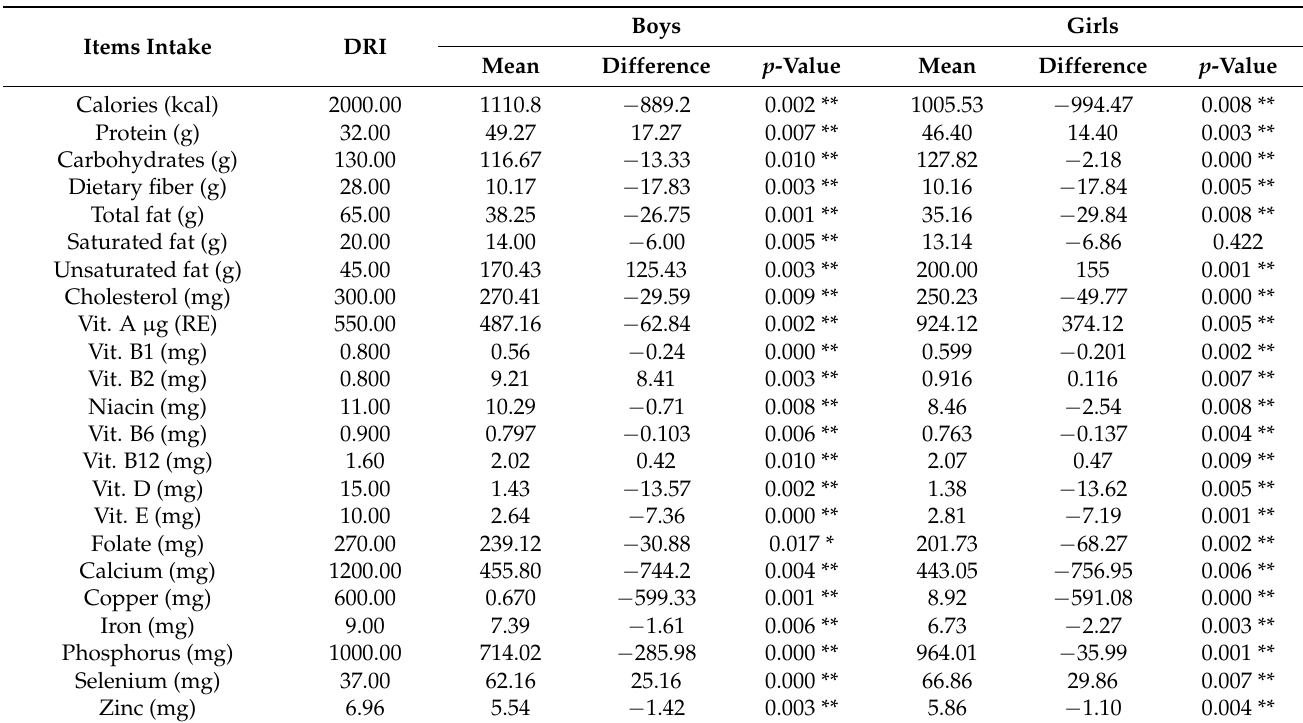
Table 3. The average intake of nutrients (24 h recall) concerning dietary reference intakes (DRI) for Syrian children using the t -test.